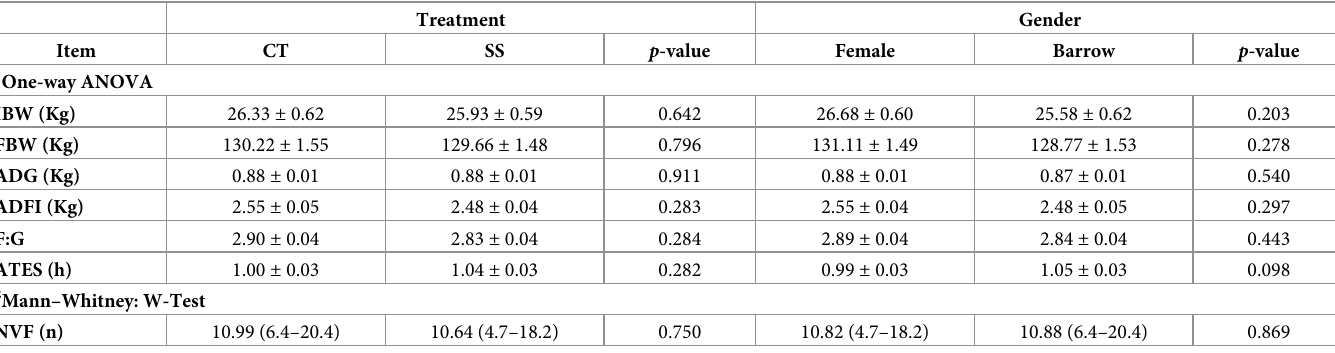
Table 2. Overall data of the performance (mean ± SE) and feeding behavior (median, min—max) of growing and finishing pigs, according to treatment and gender.